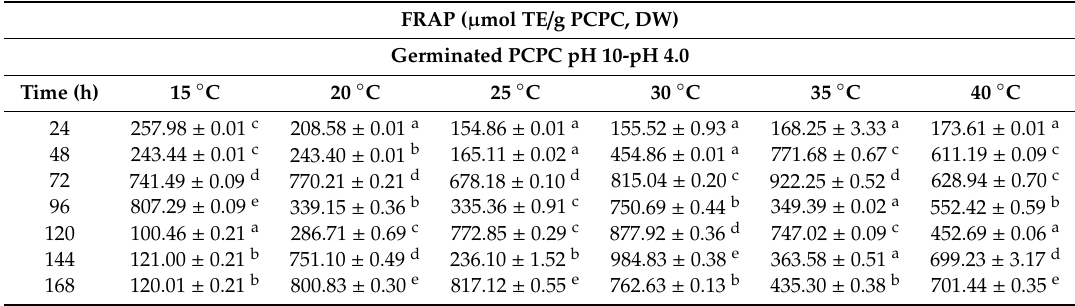
Table 5. PCPC antioxidant activity by the ferric-reducing antioxidant power (FRAP)